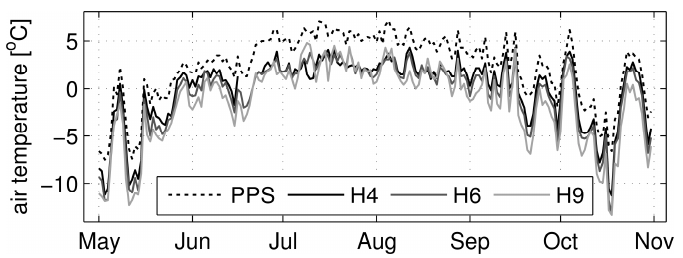
Figure 2. Air temperature changes in the 2014 melting season at the following sites: (PPS) Polish Polar Station Hornsund; (H4, H6, H9) Hansbreen. Table 3. Basic features of the snow cover at the individual study sites: (SWE) snow water equivalent; percentage of total snow depth: (IF) Ice Formations; (MFcr) Melt-Freeze Crusts.